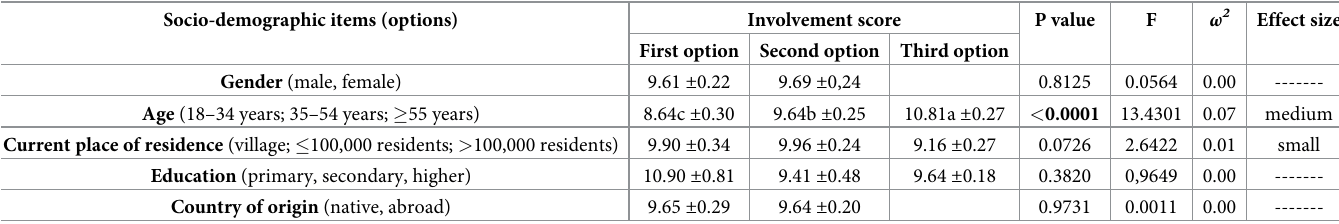
Table 2. Average involvement scores of birdwatchers in relation to their socio-demographic characteristics. Socio-demographic items